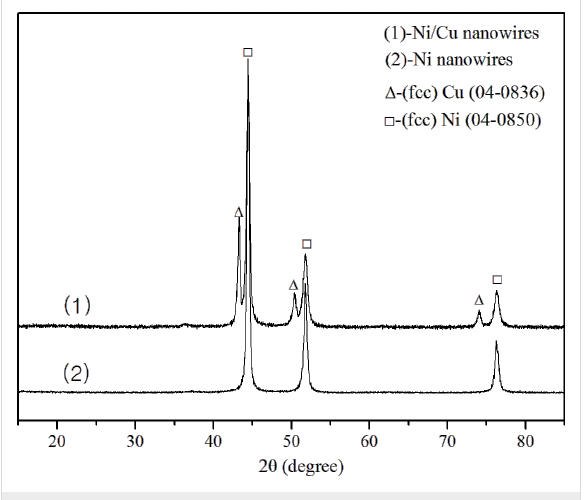
Figure 2: XRD patterns of Ni/Cu nanowires (1) and Ni nanowires